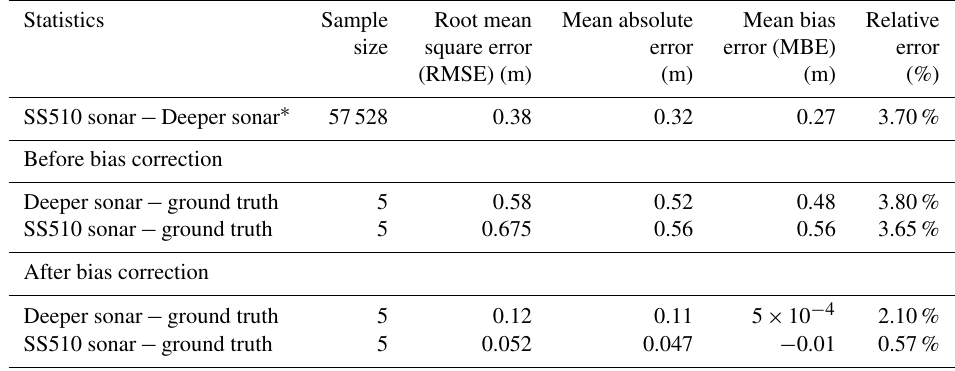
Table 1. Statistics comparing the Deeper sonar, SS510 sonar, and ground truth observations.